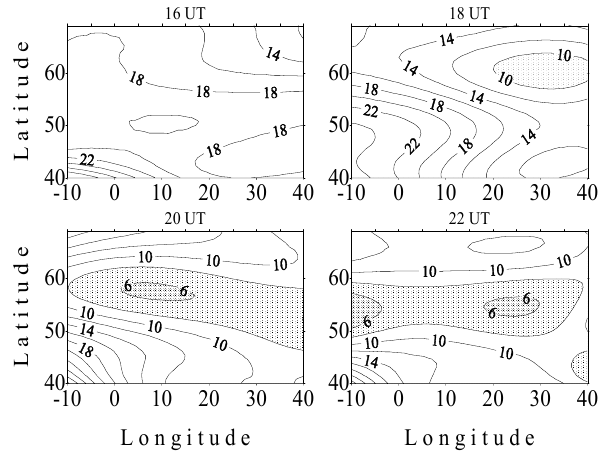
Fig. 6. TEC maps over Europe (geographic coordinates) for after- noon sector of 12 September.